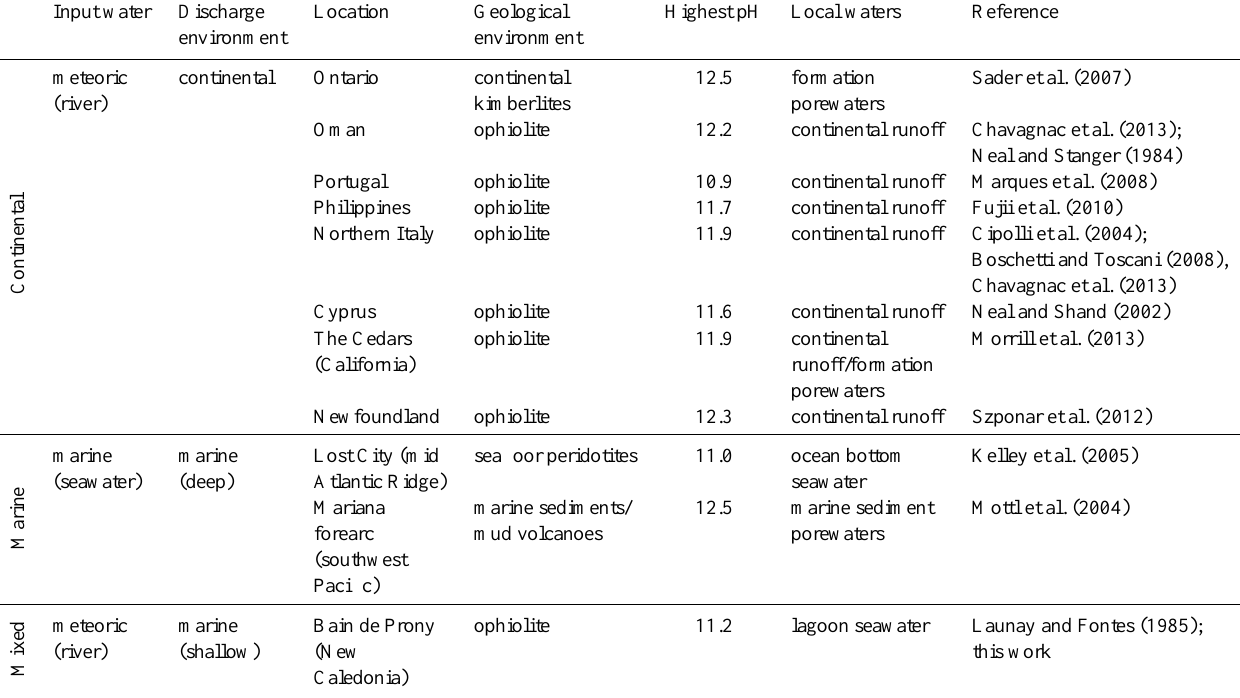
Table 1. High-pH waters worldwide. The first column (marine or continental) is the general geological environment in which the springs are found. “Input water” is the type of water entering the local hydrologic cycle. The “discharge environment” is the location of the springs, on continental surfaces or in the deep or shallow marine environment. “Local waters” are the waters that are found in the type of geological environment (for example formation waters of continental kimberlites or river waters on continental surface) that mix with the high-pH waters at some point of the hydrologic